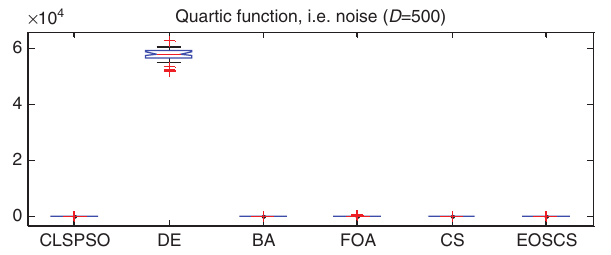
Figure 31: ANOVA Tests of The Global Minimum for F